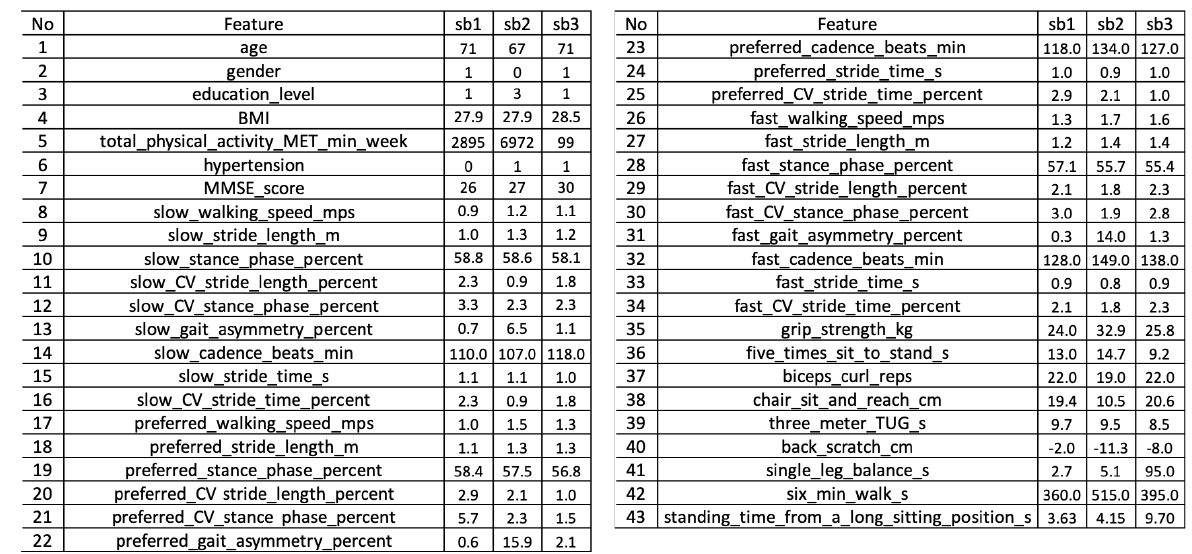
Figure 5. An example of constructed dataset for this study.